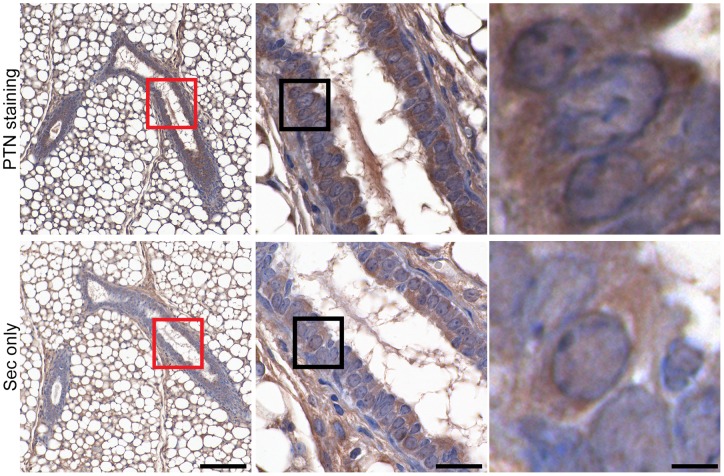
PTN protein expression in mammary glands and mammary epithelial cells (MECs).(A) Immunohistochemistry of virgin mouse mammary glands with a polyclonal anti-PTN antibody or secondary antibody only (sec. only) as a negative control. The dark brown staining shows PTN crossreactivity. Scale Bar  = 50 μm. Magnified ductal areas are indicated by the red squares (Scale Bar  = 25 μm) and individually magnified duct epithelial cells by the black squares (Scale Bar  = 10 μm).